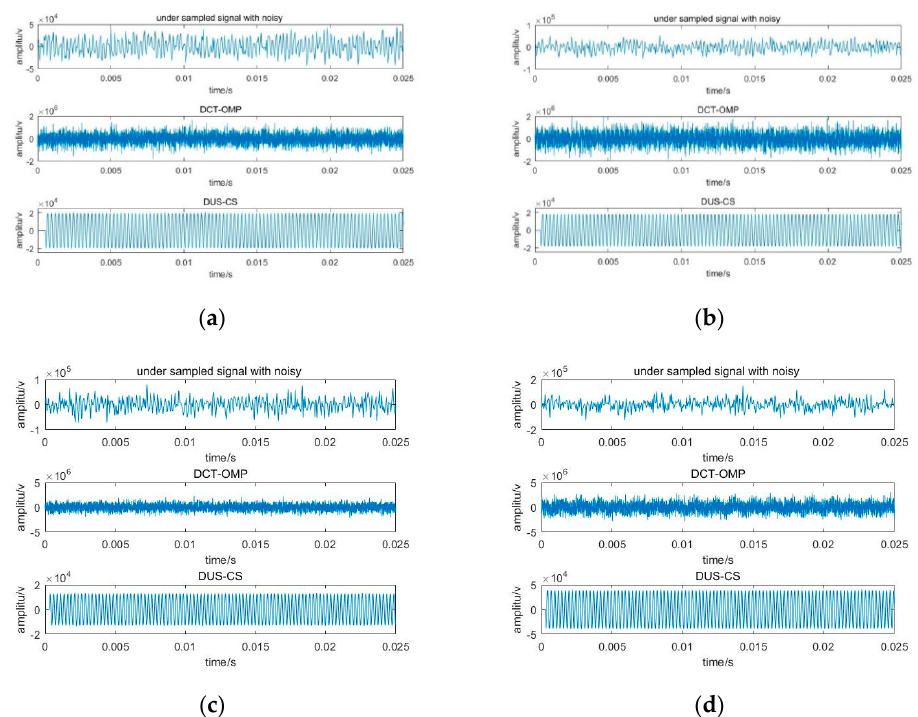
Figure 12. Reconstruction results with compression ratio of 10%. ( a ) SNR = 3 dB; ( b ) SNR = 0 dB; ( c ) SNR = − 3 dB; ( d ) SNR = − 8